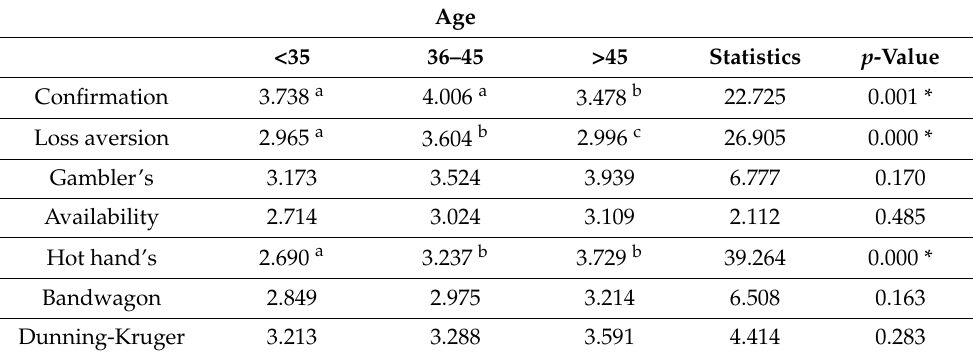
Table 2. Fallacies based on age.